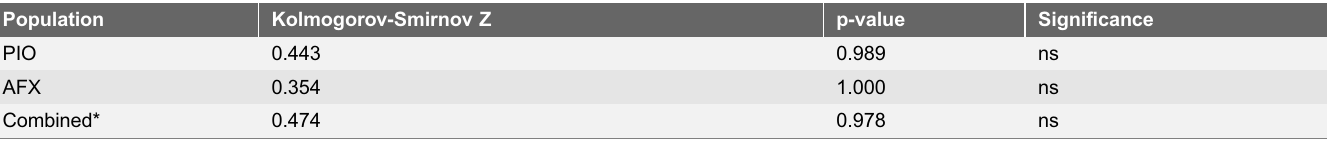
Table 3. Evaluation of disease severity scores from two F 1 mapping populations (PIO and AFX) for normal distribution using the Kolmogorov-Smirnov tests. Population